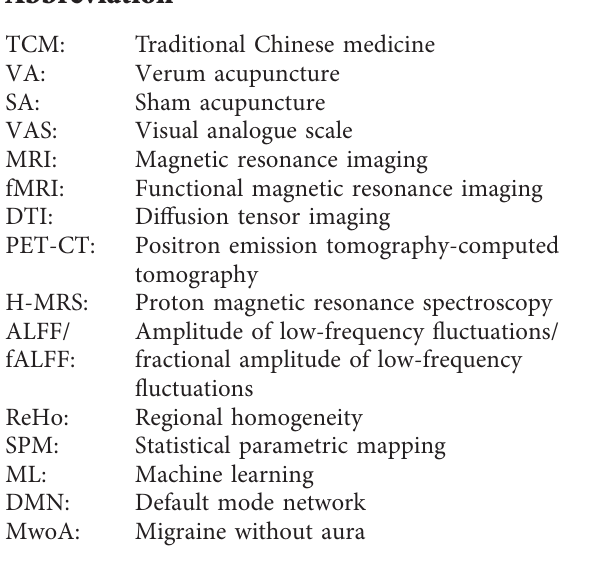
Supplementary Table 1. Full search strategy for each of the electronic databases queried. Supplementary Table 2. The basic information of the included studies. Supplementary Table 3. The study design of the included studies. Supple- mentary Table 4. The neuroimage information of the in- cluded studies. Supplementary Figure 1. The flow diagram of the literature search and screening process. Supplementary Figure 2. The basic information of the included